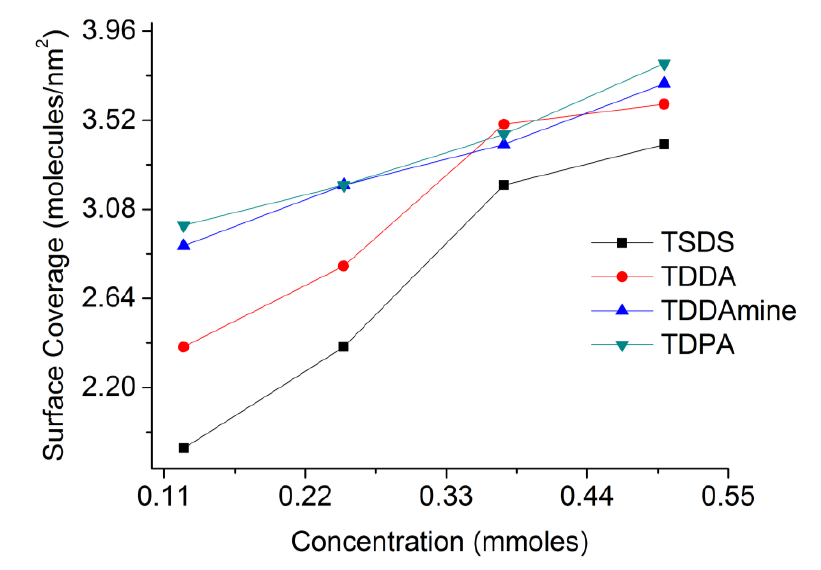
Figure 13. Effect of concentration on surface coverage of titania by the coupling